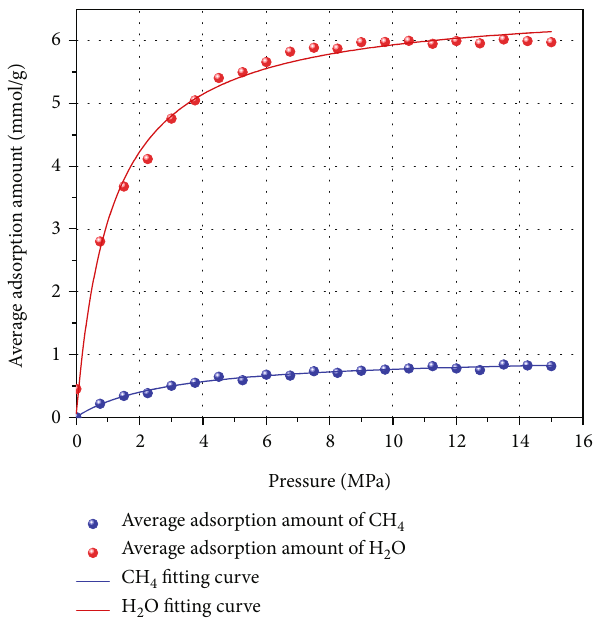
Figure 5: Single-component isothermal adsorption curve at 303.15K.